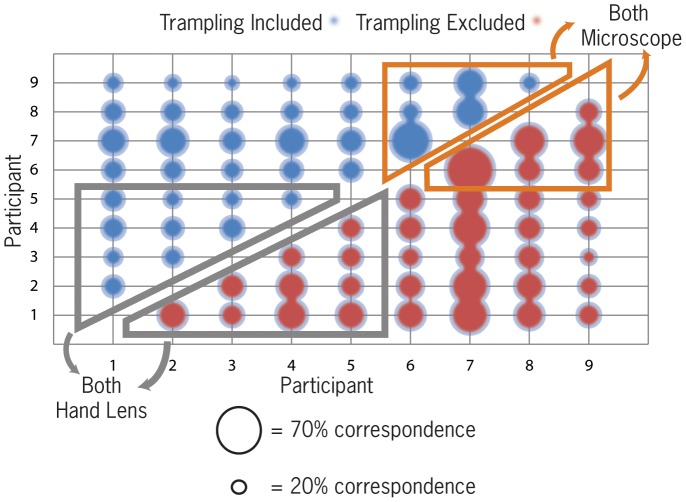
Two-way correspondence scores for participants within each instrumentation group diagnosing modifications.Correspondence scores that include trampling marks are in red and correspondence scores that exclude trampling marks are in blue.